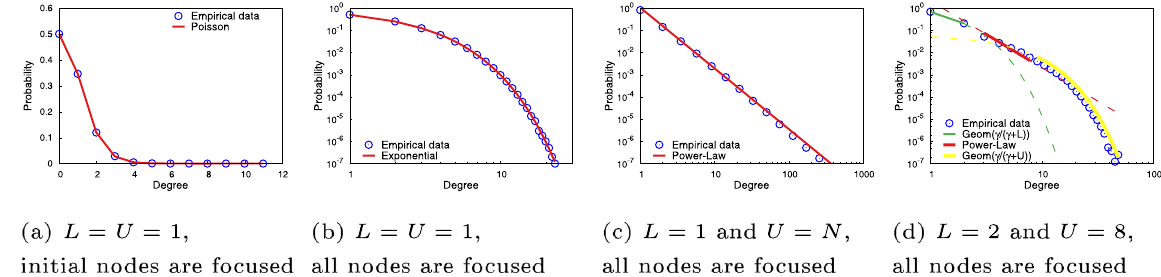
Figure 2. Simulation results of node-degree distribution on the MC model with varying L and U . The blue circle points represent the empirical probability density function (PDF). The red solid line represents the theoretical prediction of the PDF. In ( c , d ), the empirical PDF was plotted using logarithmic binning to avoid over-fitting due to large variations in the tails.